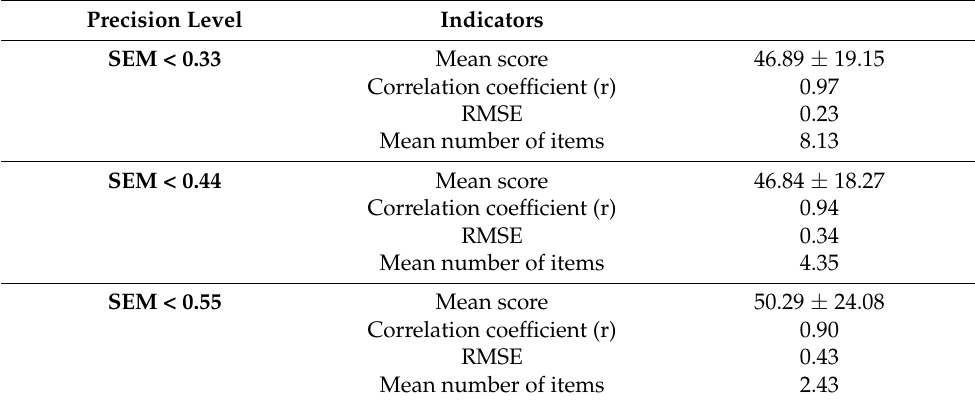
Table 4. Mean scores and precision indicators for each CAT